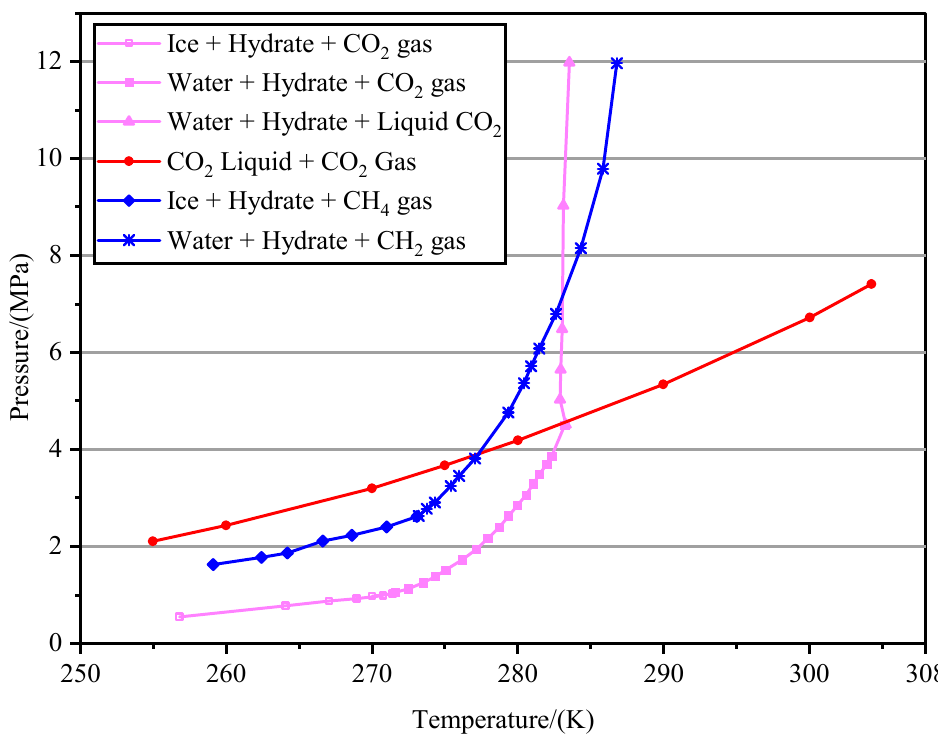
Figure 1. Phase equilibrium relation of CO 2 and CH 4 hydrate in this study.